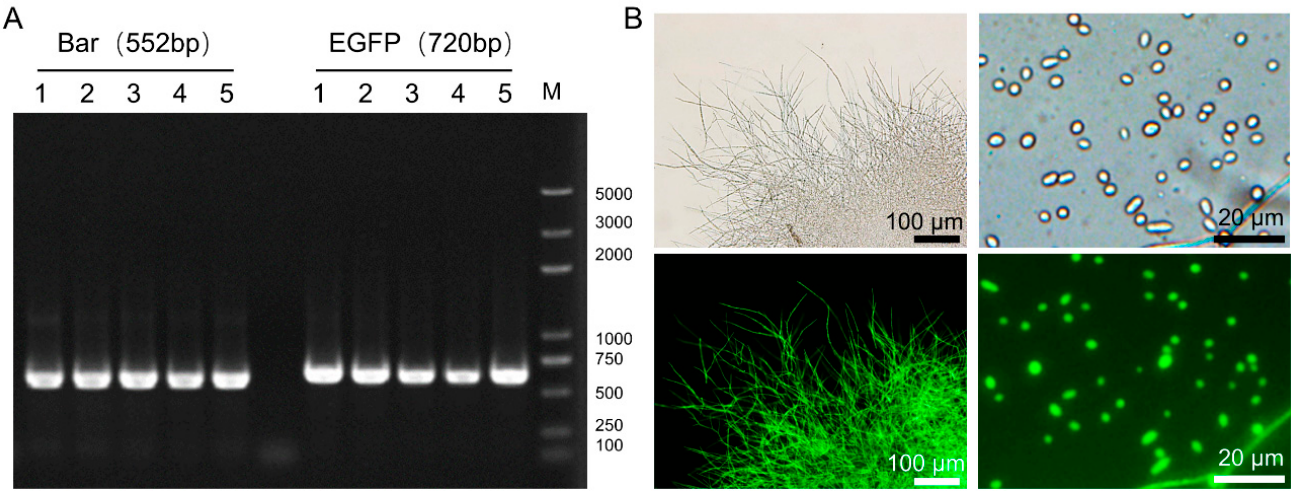
Figure 2. Verification of C. farinosa transformants. ( A ) Amplification of total DNA extracted from putative transformants with Bar and EGFP primers. ( B ) Fluorescence observation of putative transformants.